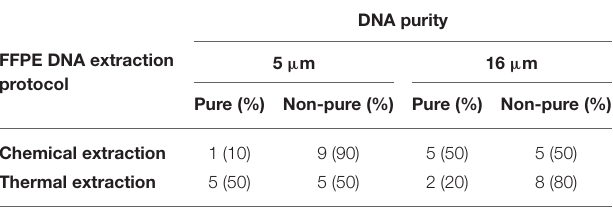
FFPE DNA extraction